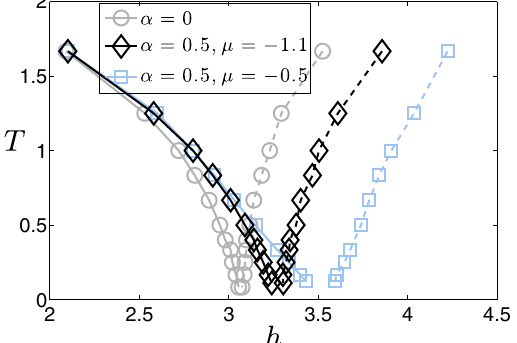
FIG. 4. The phase diagram for several sets of parameters. Gray circles represent the decoupled problem ( α ¼ 0 ), while black diamonds and blue squares represent the coupled problem ( α ¼ 0 . 5 ) at 0.6 and 0.8 fermions per site, respectively.